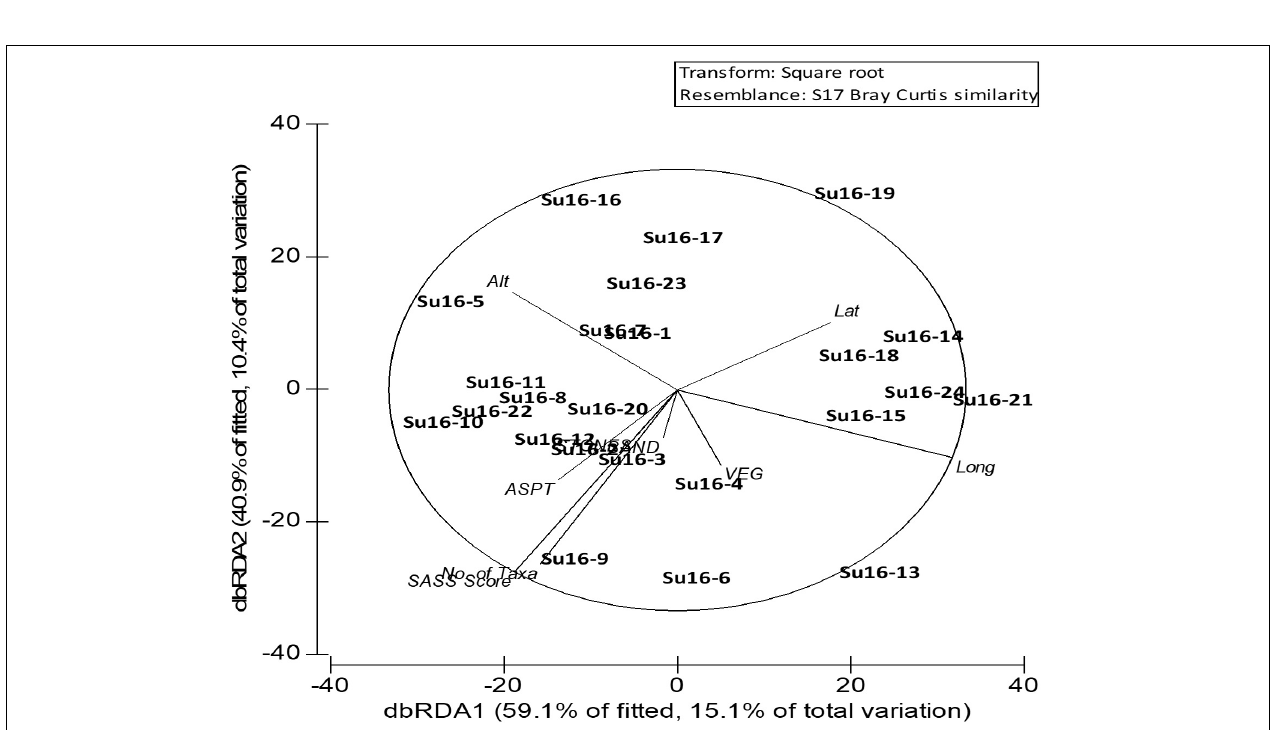
FIGURE 2 | Non-metric multidimensional scaling (MDS) ordination showing the classification of sites based on macroinvertebrate taxa collected in summer 2016 in rivers of KwaZulu-Natal, South Africa. Sites were coded by group geomorphology (upland and lowland) and the shapes represent the ecoregions. SEU, south eastern uplands; NECB, north eastern coastal belt; EEM, eastern escarpment mountains; NEU, north eastern uplands; LOWV, lowveld.